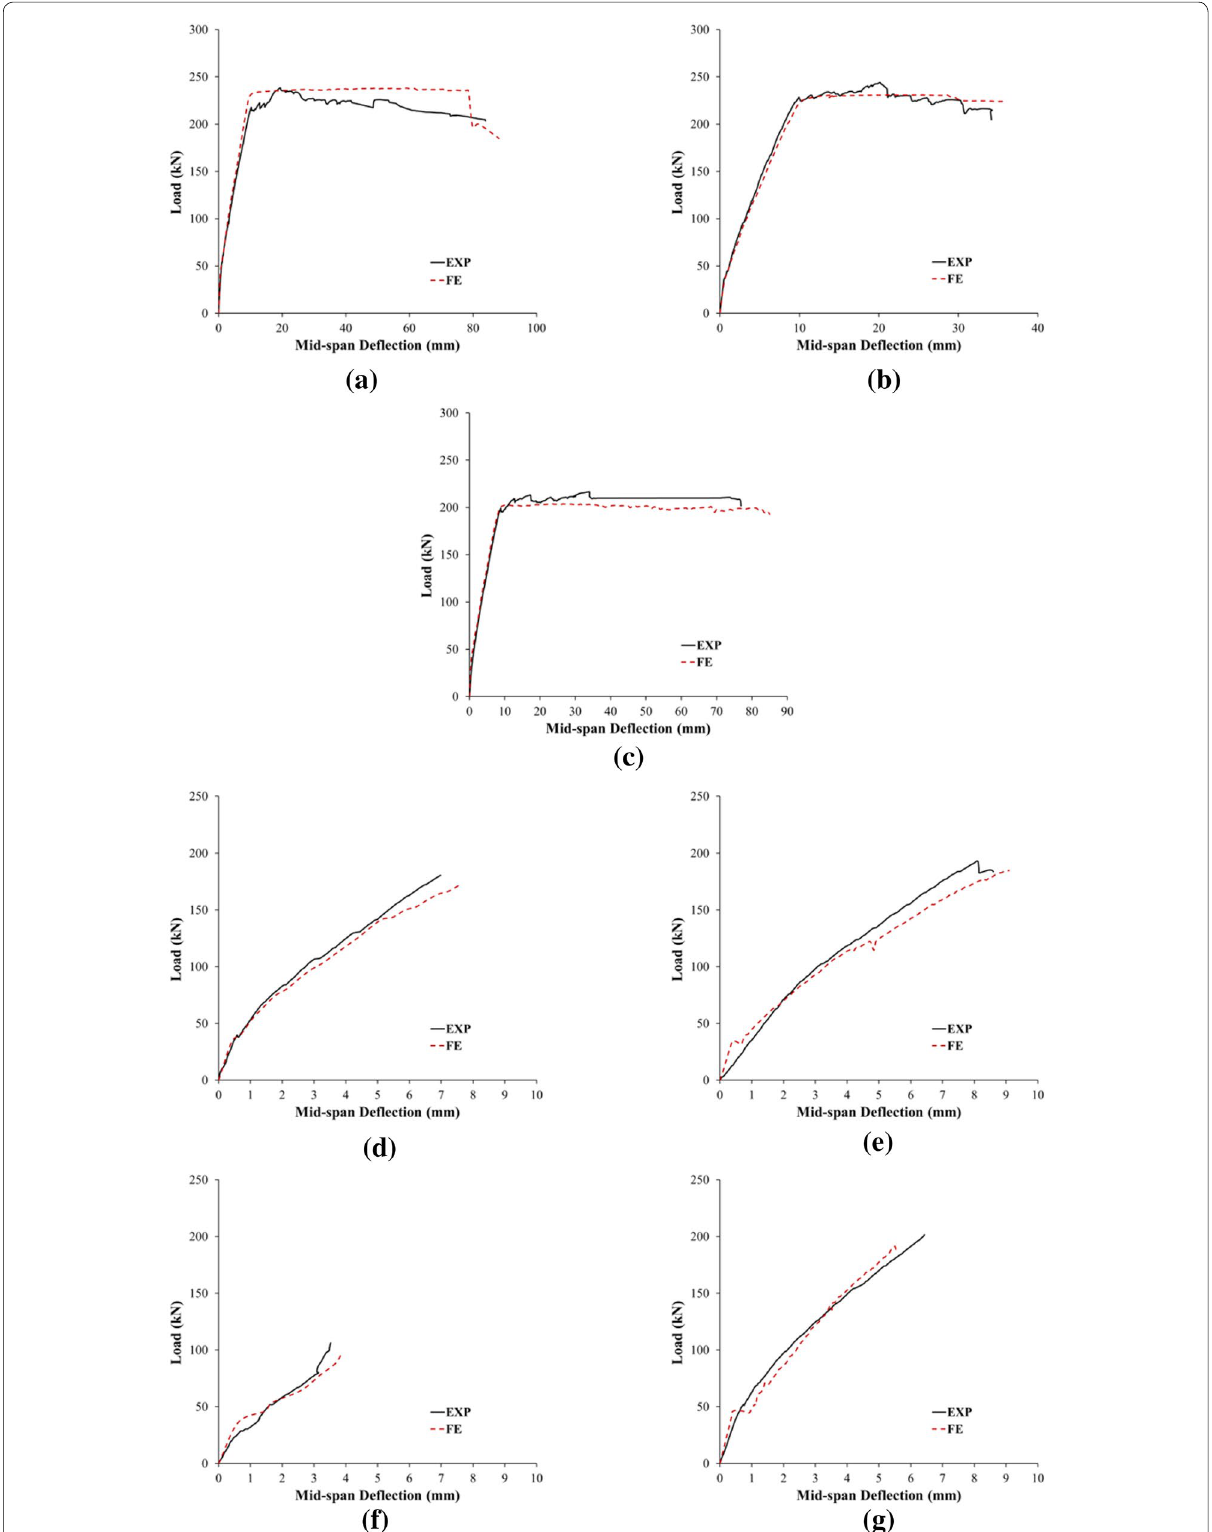
Fig. 13 Load‑deflection comparison curves for: a BC‑N‑4PB, b BC‑O1‑4PB, c BC‑N‑CPL, d BC‑O1‑CPL, e BS1‑O1‑CPL, f BC‑O2‑CPL, and g